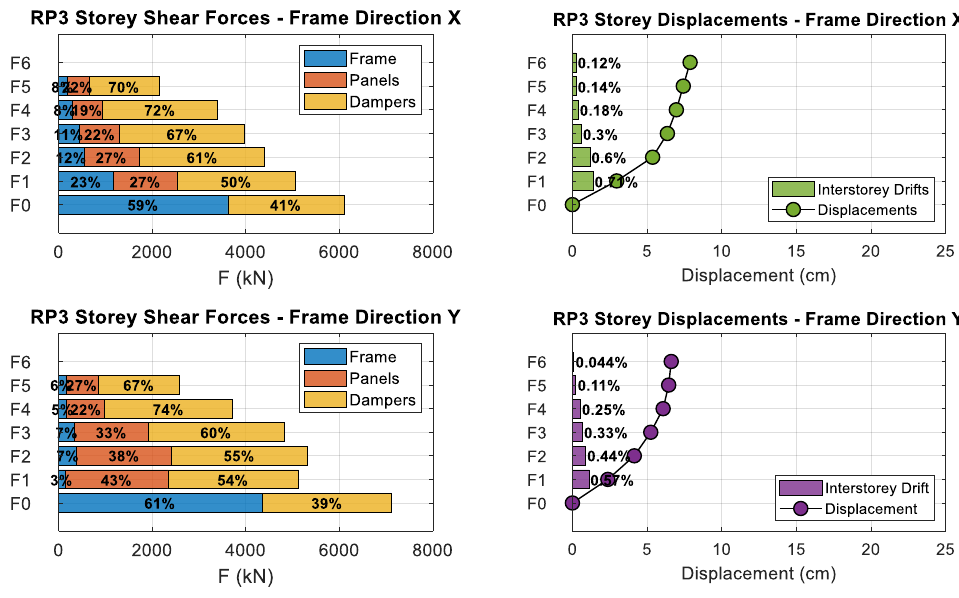
Figure 19. RP3 storey shear forces and displacements.